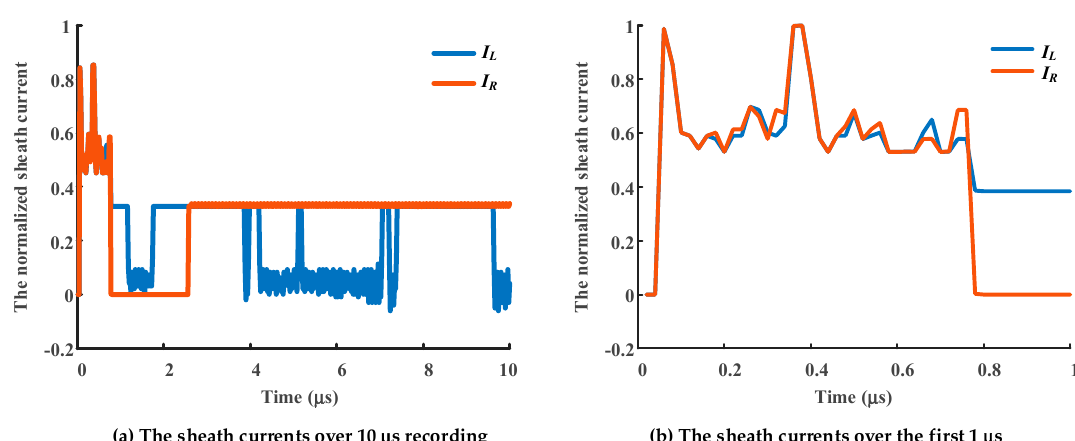
Figure 24. Normalized sheath currents recorded by the current sensors at the positions shown. ( I L is the sheath current recorded by the sensor to the left of the fault, I R is the sheath current recorded by the sensor to the right of the fault.).